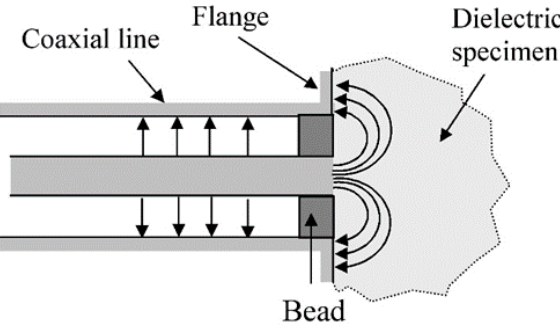
Figure 1. Schematic of coaxial sensor. Complex permittivity is determined from the complex reflection coefficient measured by using a vector network analyser (VNA).